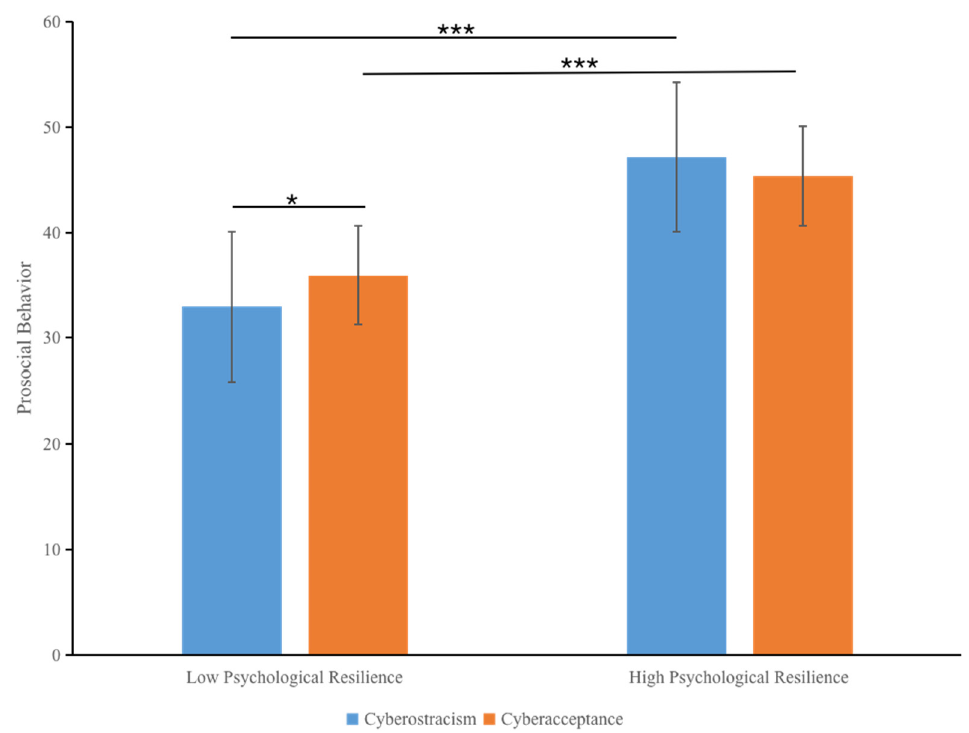
Figure 1. Effects of psychological resilience and cyberostracism on prosocial behavior. Error bars represent the 95% confidence interval. Note. * p < 0.05, *** p < 0.001.